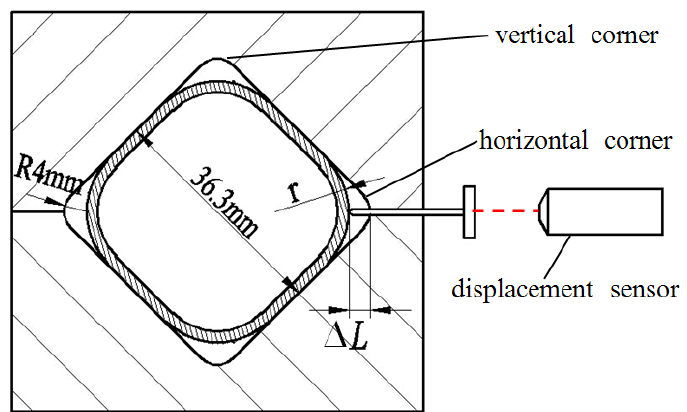
Figure 1. Round-to-square die